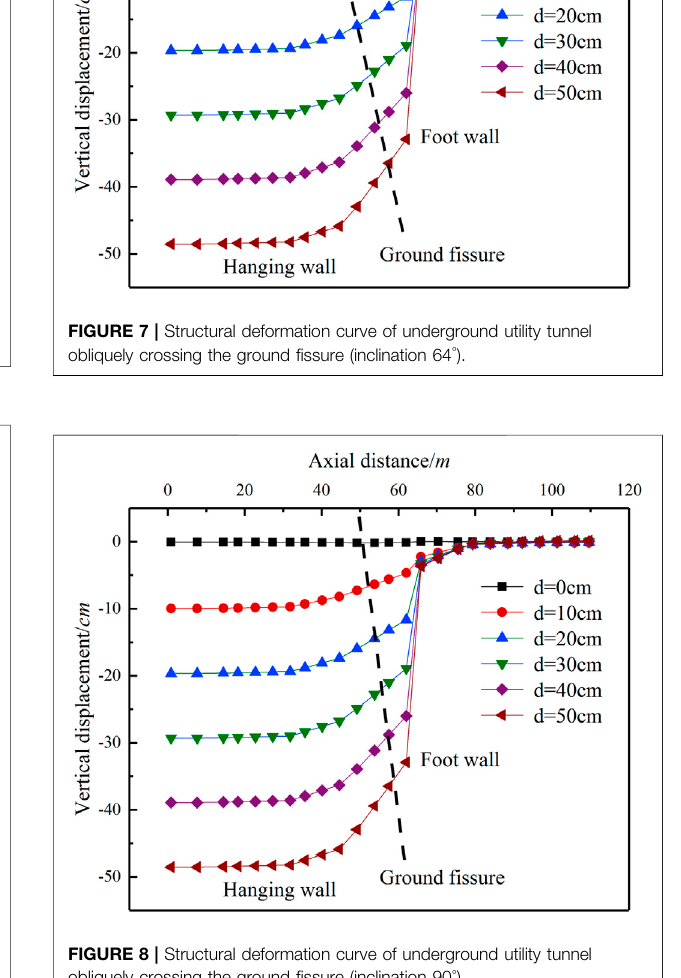
Frontiers in Earth Science |